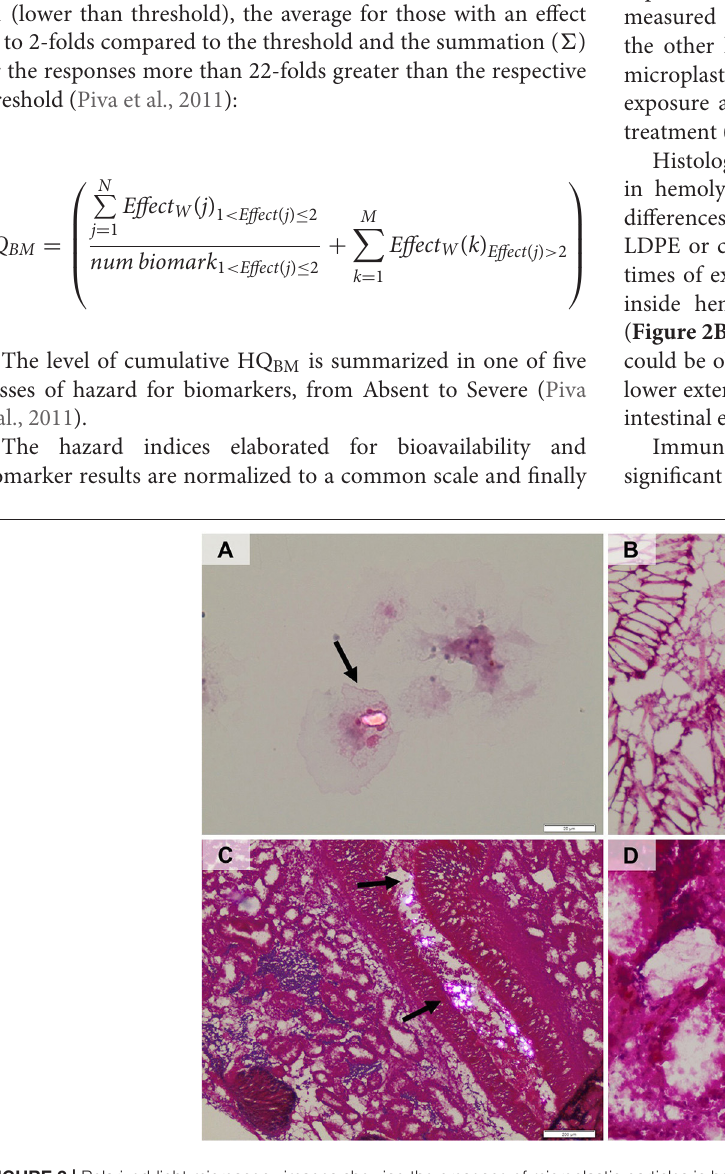
Frontiers in Marine Science |